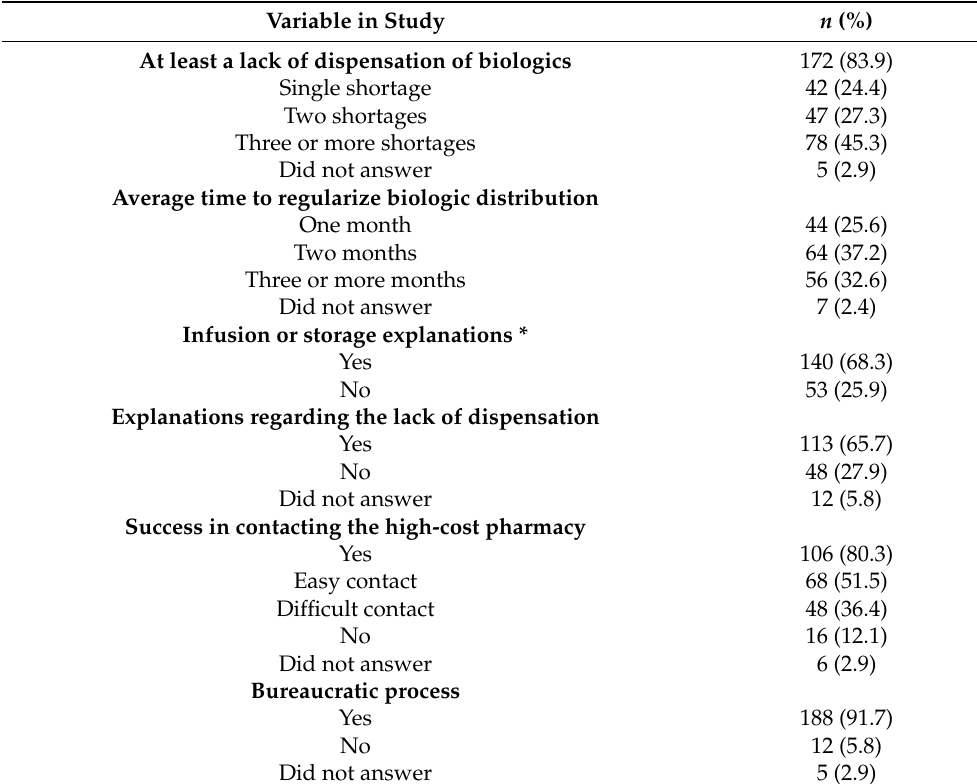
Table 2. Lack of biologics and patient